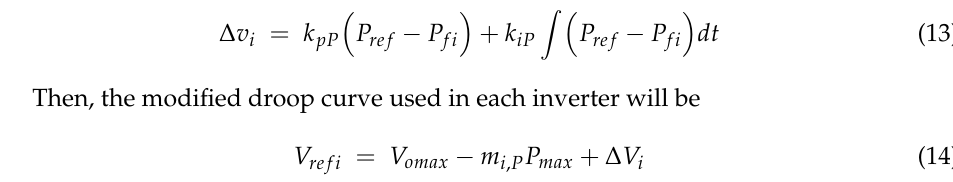
Figure 5. Statism curves P–V ( left ) and Q–f ( right ).